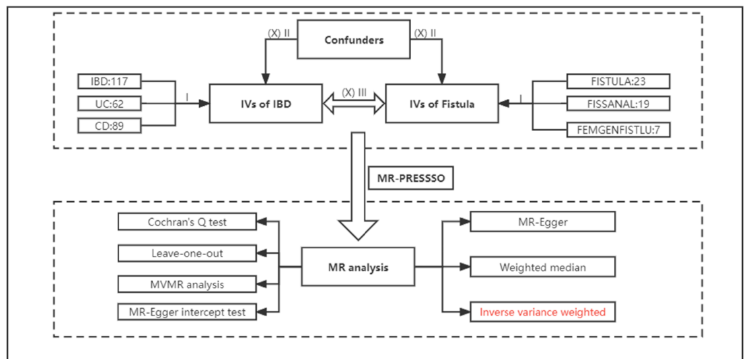
Figure 1. The workflow of this